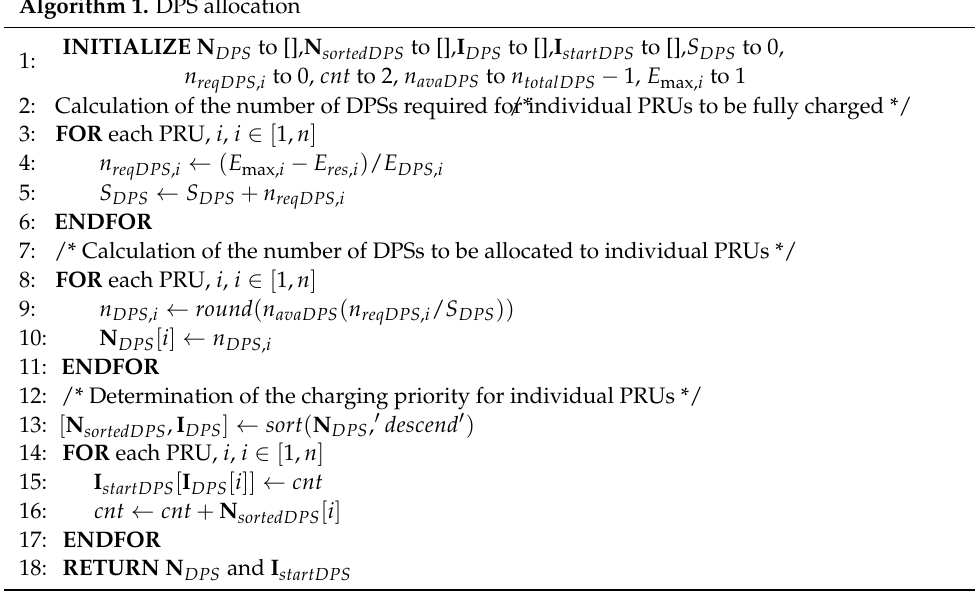
Algorithm 1. DPS